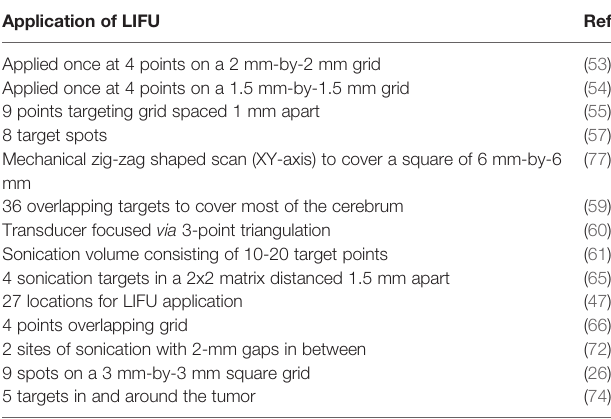
TABLE 4 | Targeting strategies utilized by different preclinical studies to cover the whole tumor volume or its in fi ltrating volume or sometimes a whole